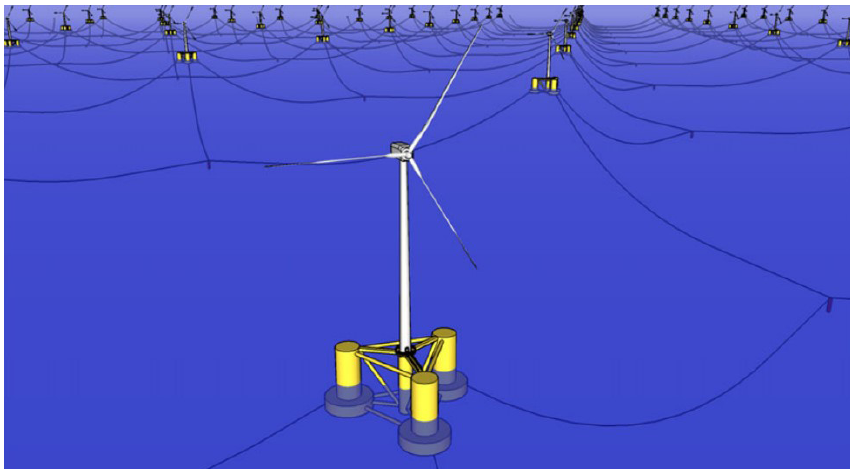
Figure 10. Shared-anchor system (Fontana et al.,